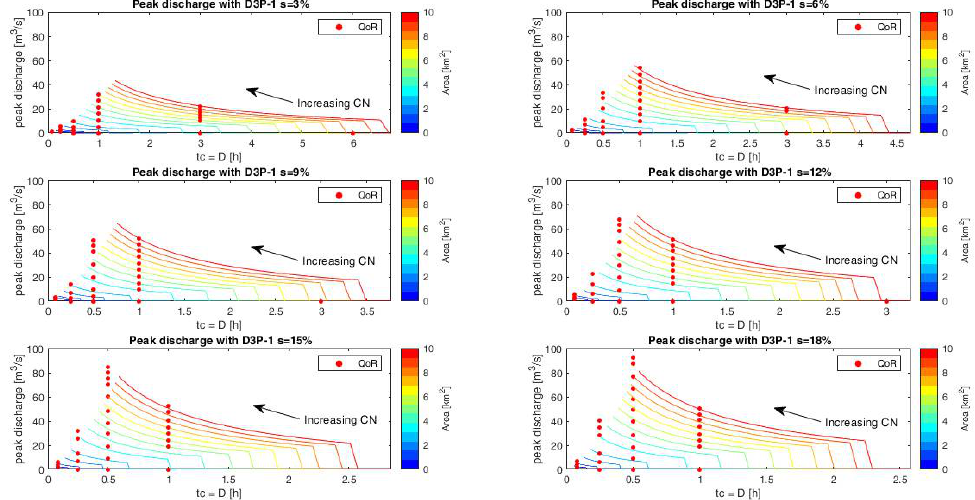
Figure 8. Peak curves obtained with D3P-1 vs. Q-Peak (red dots) evaluated with observed Rainfall.